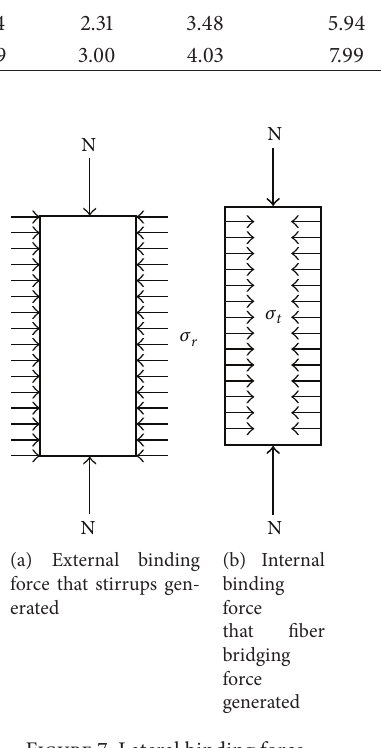
Figure 7: Lateral binding force.